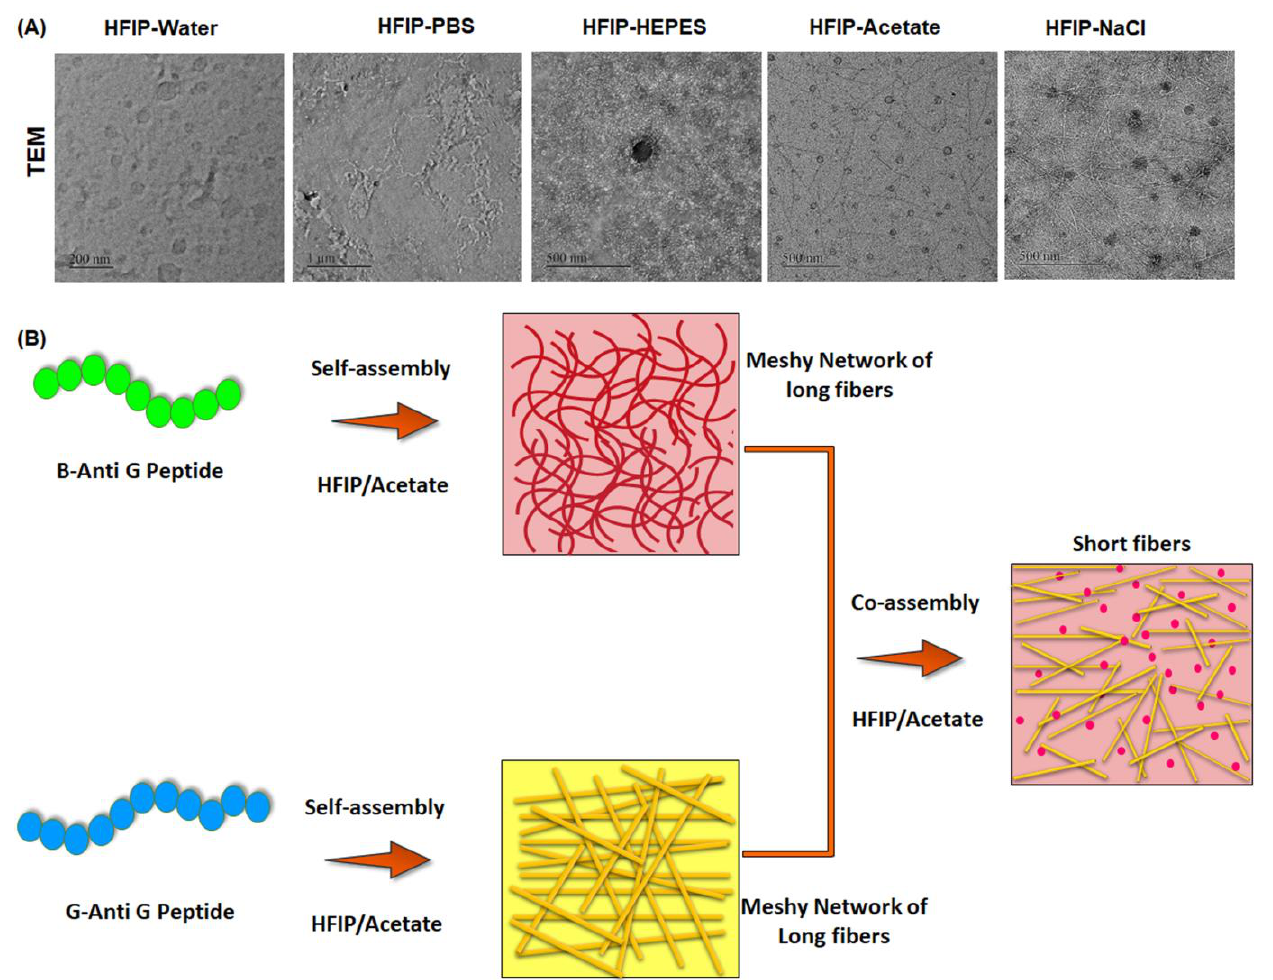
Figure 2. ( A ) Transmission electron micrographs of peptide-based co-assembled nanostructures (PNPs) formed in various HFIP–buffer mixtures. ( B ) Illustration representing peptide co-assemblies as an innovative class of naive, multifunctional, bio-inspired supramolecular constructs.